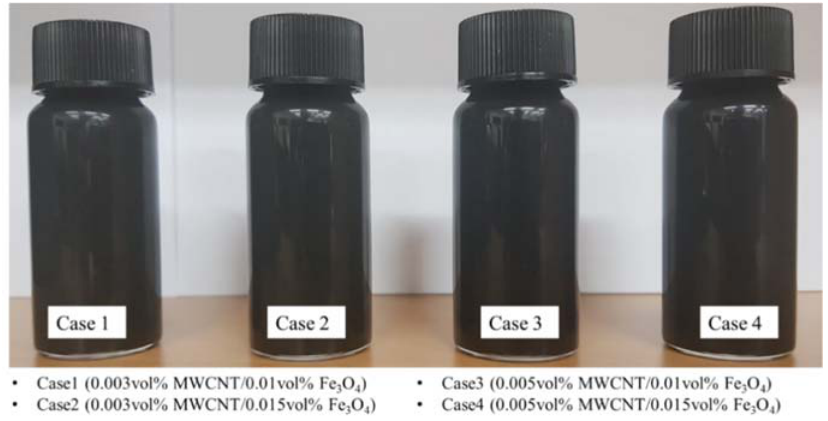
Figure 4. Pictures of four MWCNT/Fe 3 O 4 binary nanofluids.